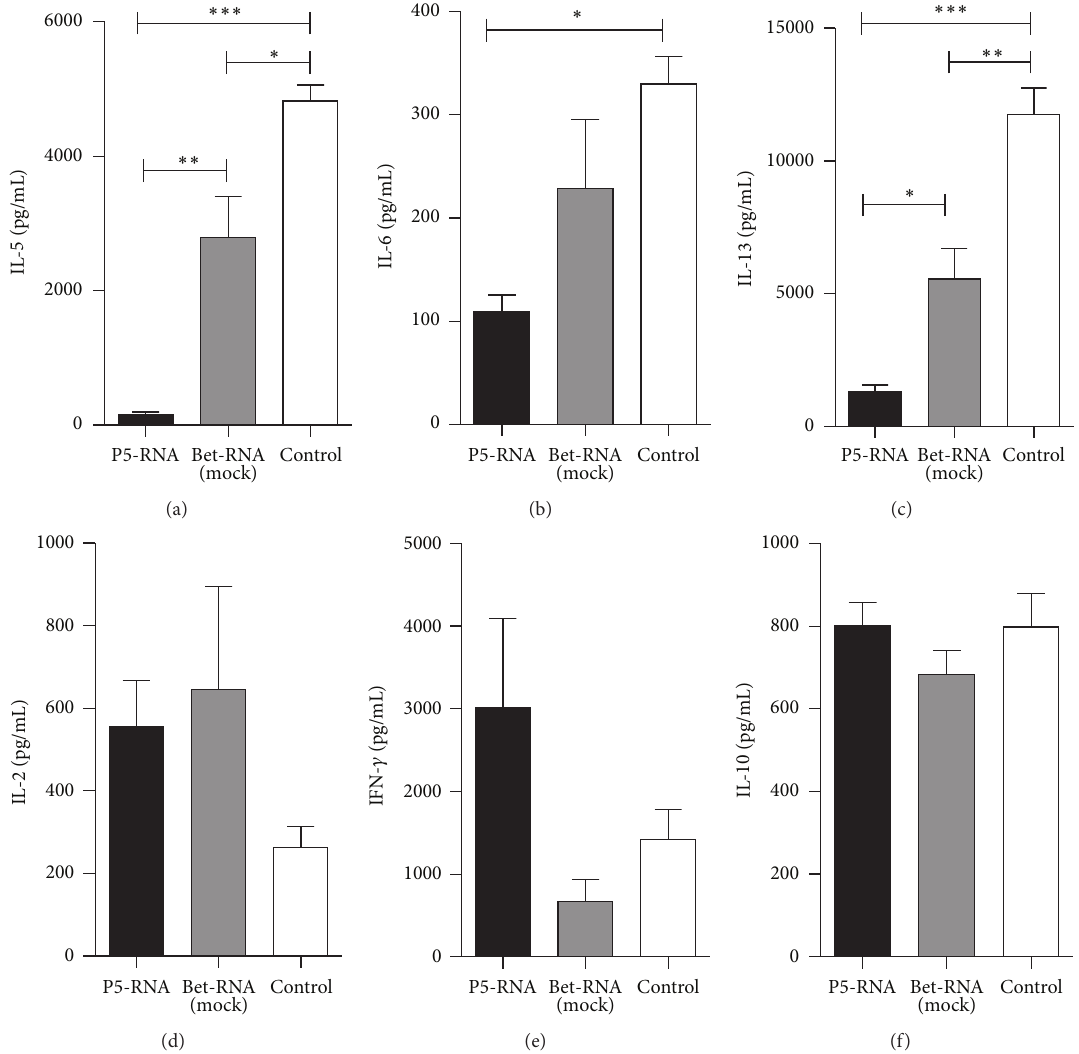
Figure 5: Levels of IL-5 (a), IL-6 (b), IL-13 (c), IL-2 (d), IFN- 𝛾 (e), and IL-10 (f) in supernatants of in vitro restimulated splenocyte cultures. Cells were obtained from mice immunized 9 months before, sensitized, and repeatedly exposed to aerosolized rPhl p 5. Data are displayed as means ± SEM ( 𝑛 = 5 ). ∗ 𝑝 < 0.05 ; ∗∗ 𝑝 < 0.01 ; ∗∗∗ 𝑝 < 0.001